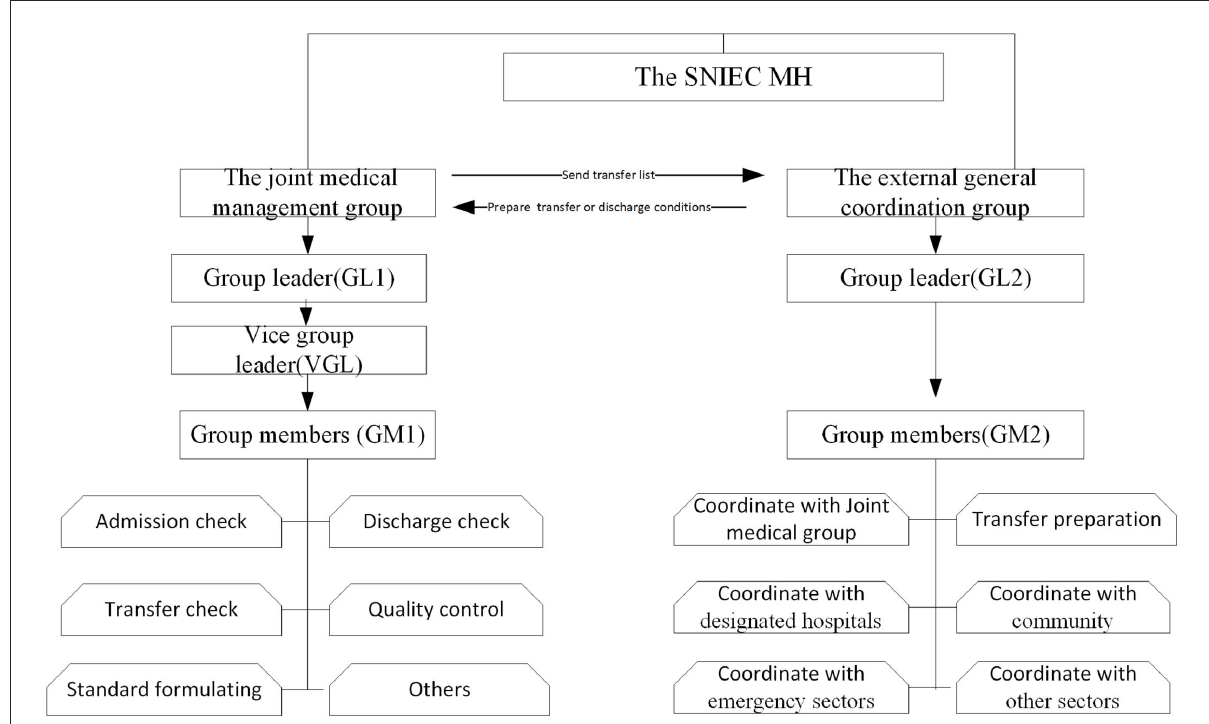
FIGURE2 The work mechanism and organization structure of management groups in the SNIEC MH Group professional requirements: GL1: held by the chief physician and senior hospital administrator, VGL: held by the attending physician and the youth hospital manager, and GM1: consisting of some senior specialized senior chief physicians or attending physicians. GL2: held by one chief physician and one middle-aged hospital manager, GM2: consisting of hospital management majors, middle-aged hospital managers, attending physicians and junior medical